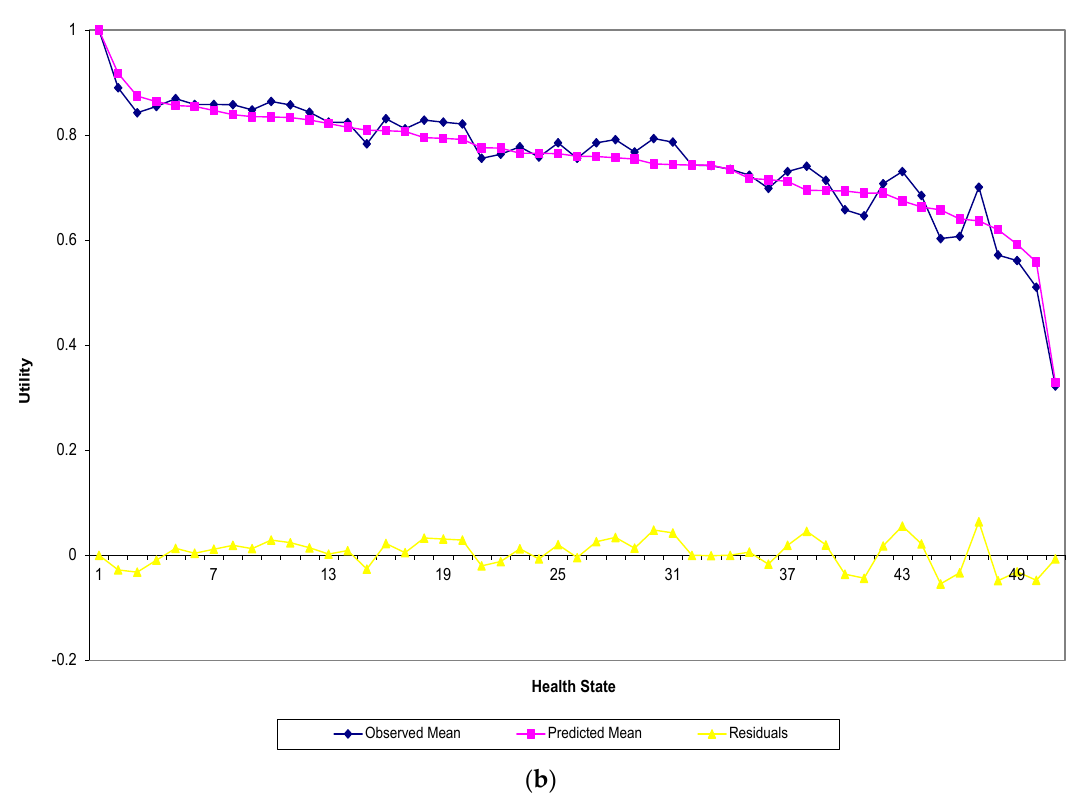
Figure 1. Actual and predicted mean health states valuations for ( a ) the crude model and ( b ) model (1).